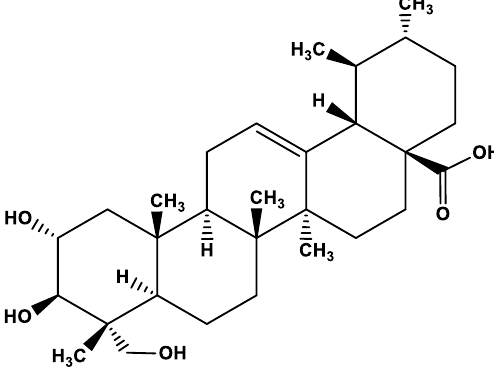
Figure 1. Chemical structure of asiatic